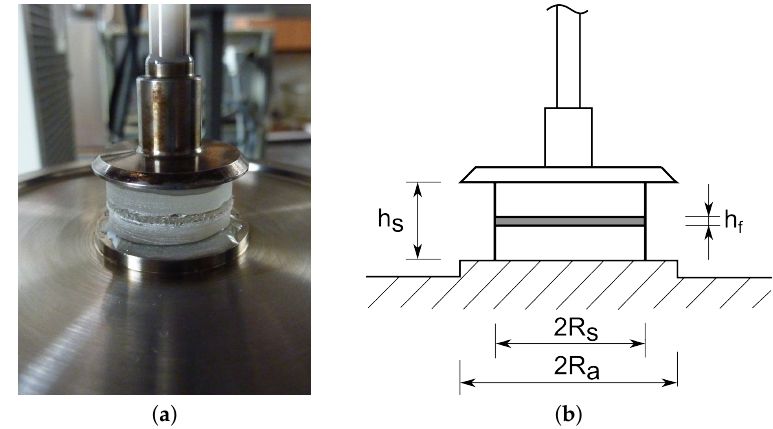
Figure 9. Rheometer device: ( a ) mounted sample, ( b ) geometrical